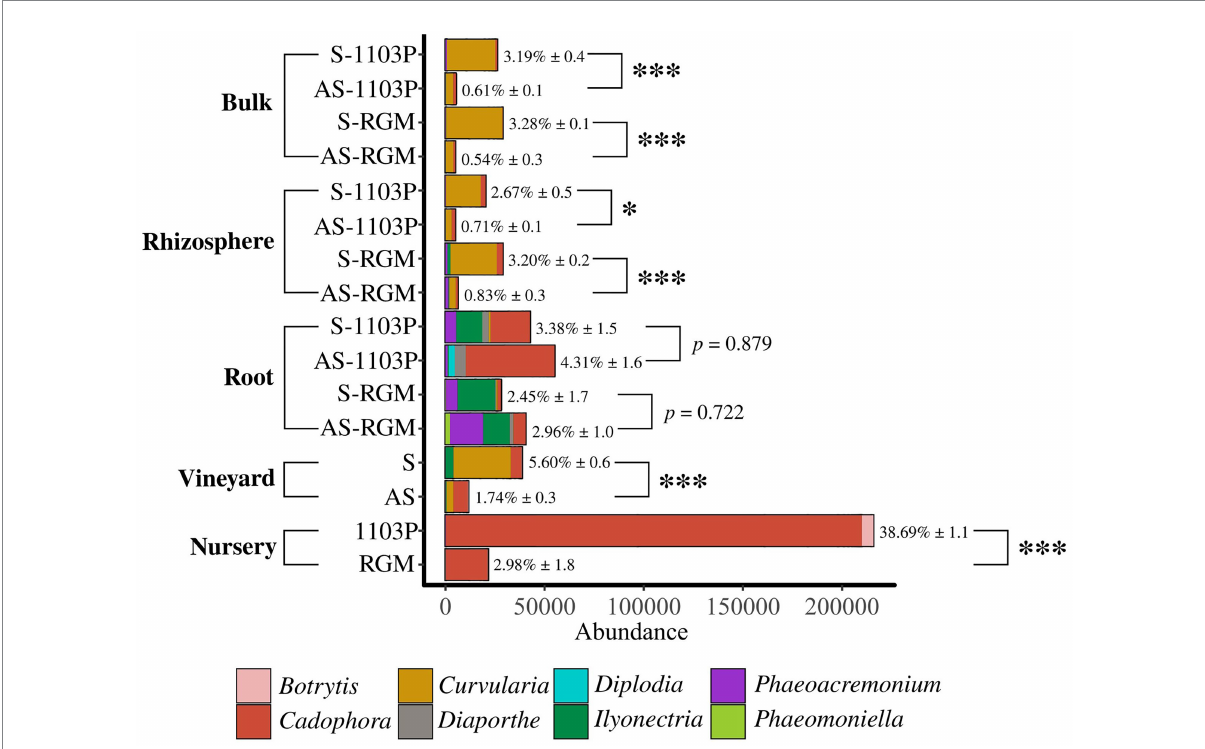
FIGURE 5 Abundance of fungal genera associated to grapevine diseases in the different compartments related to greenhouse experiments. Roots from nursery plants before plantation, S and AS soils from vineyard before the greenhouse experiments, and bulk soils, rhizosphere and roots of 1103P and RGM rootstocks grafted with CS after 4.5 months of growth either in S or AS soils. Percentages (± SE) indicate proportions of sequences affiliated with pathogenic fungi relative to total sequences. Significant differences ( * p < 0.05; *** p < 0.001) between compared conditions were detected with Student t or Wilcoxon